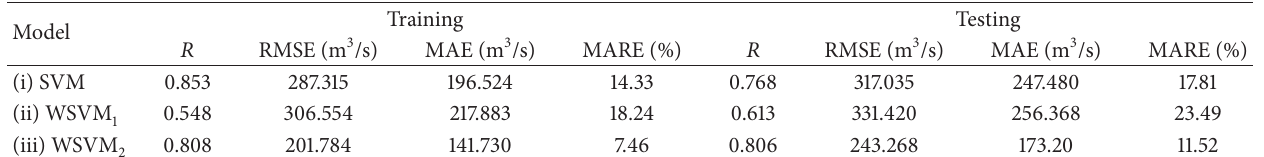
Table 3: Forecasting performance indexes of SVM and WSVM models in Tangnaihai station.